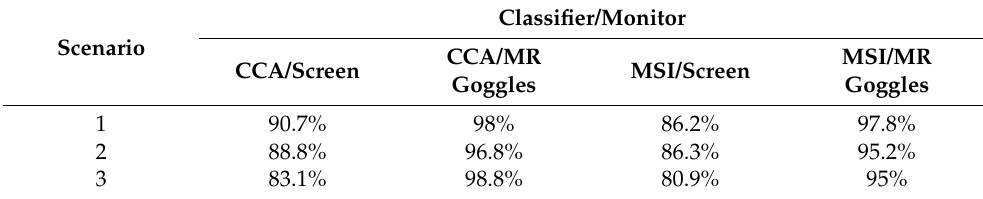
Table 16. Comparison of all